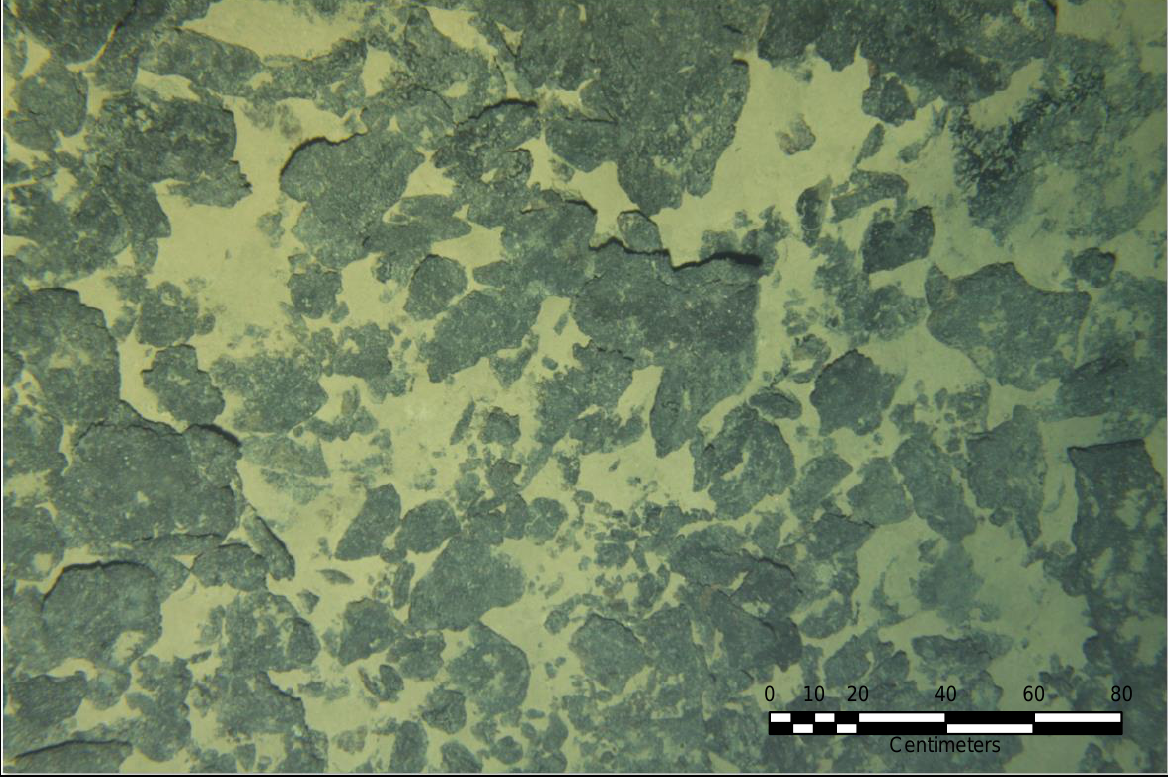
Figure 12. Volcanic knoll crest example photo. Source: TOML image 2015_08_17_094309.